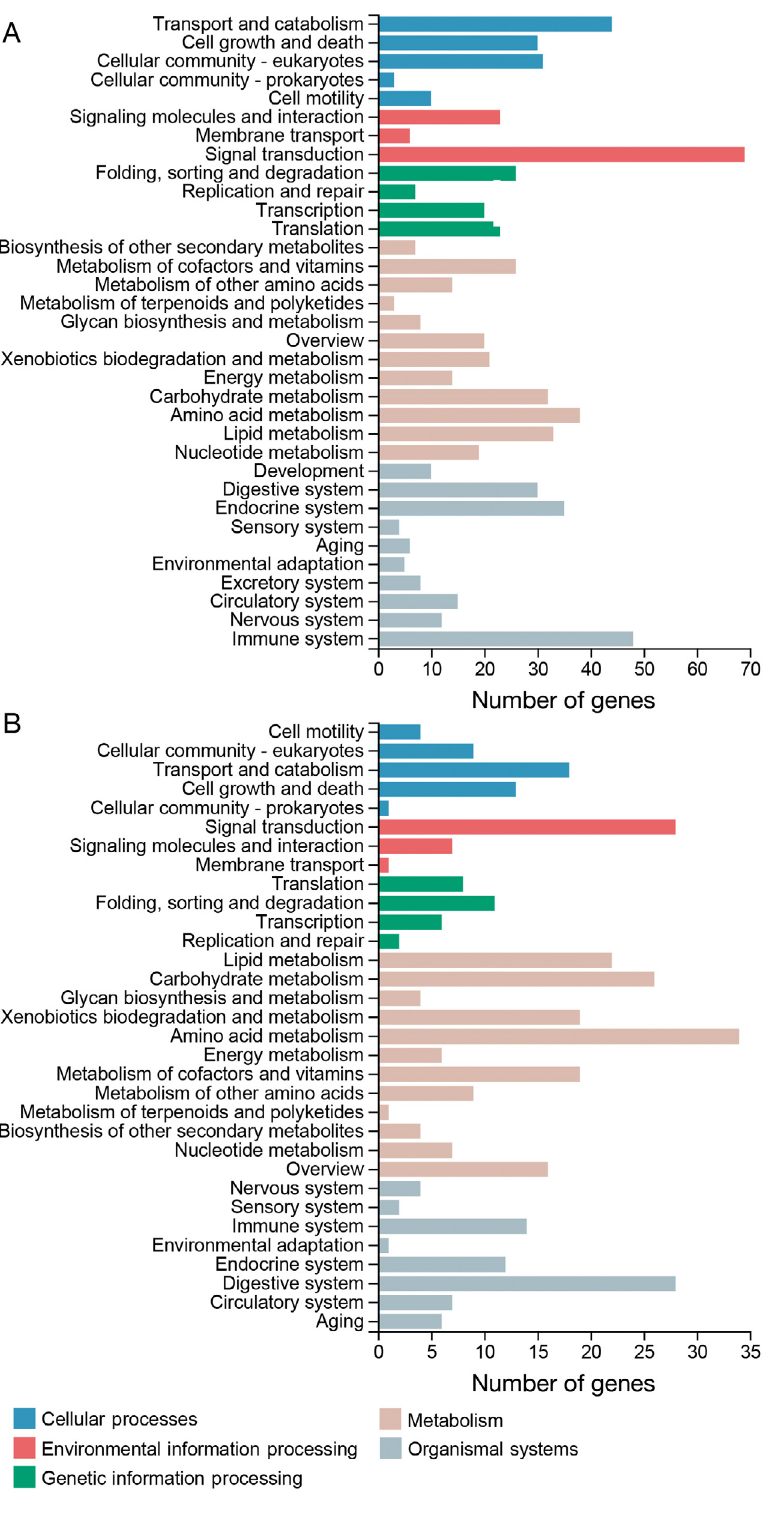
Fig. 5. KEGG pathway enrichment based on the differentially expressed genes (DEGs) of the yellow drum (A) 8unfed-vs.-16fed and (B)16unfed-vs. -16fed groups. Horizontal axis shows the number of DEGs enriched in each